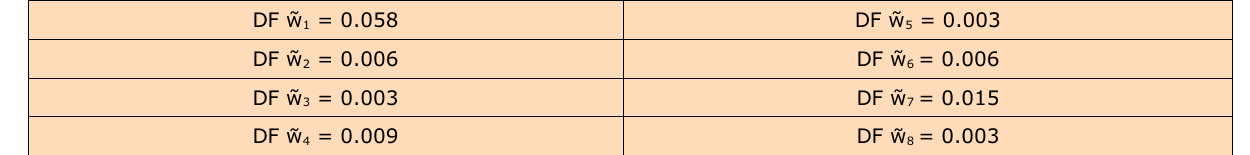
Table 11. defuzzified mean value of weights of hazard